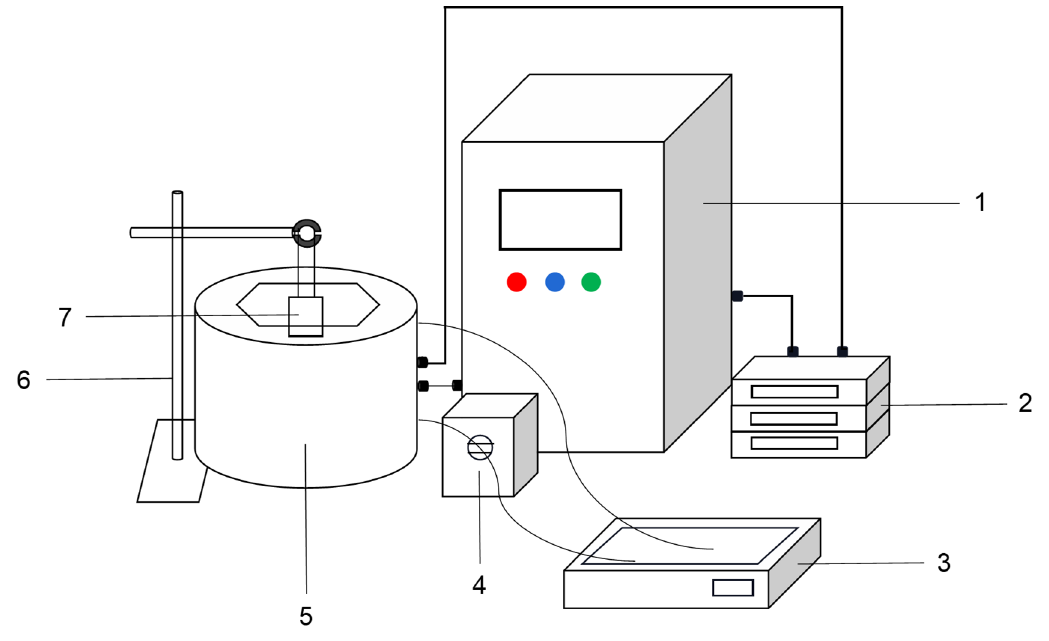
Figure 1. Divergent tri-frequency ultrasound equipment (Note: 1. Control panel, 2. Ultrasonic generator, 3. Constant temperature water bath pot, 4. Peristaltic pump, 5. Reactor, 6. Iron rack table, 7. Potato protein solution).